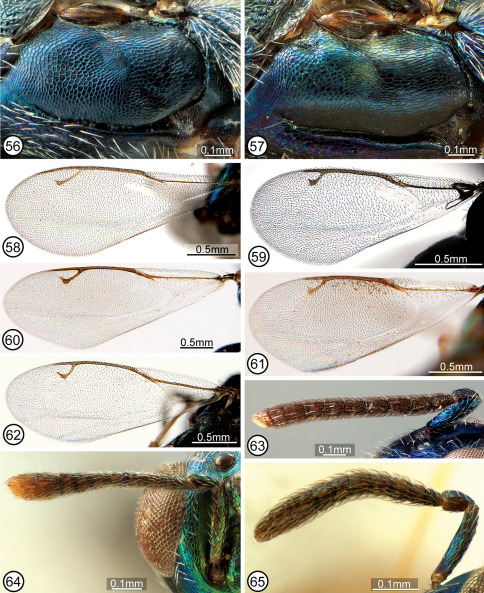
56−57 lateral mesosoma/acropleuron: 56 Calosota obscura ♀ (45: France, CNC) 57 Calosota lixobia (♂ paratype). 58−62 fore wing: 58 Calosota acron ♀ (48) 59 Calosota metallica ♀ (27) 60 Calosota aestivalis ♀ (47) 61 Calosota bicolorata ♂ (46) 62 Calosota longivena (42). 63−65 ♂ antenna: 63 Calosota metallica (34) 64 Calosota grylli (35: Yugoslavia, NMPC) 65 Calosota sp. (36: Spain, BMNH). Numbers in parentheses = CNC Photo 2009-no. Abbreviation: lmp = lower mesepimeron.